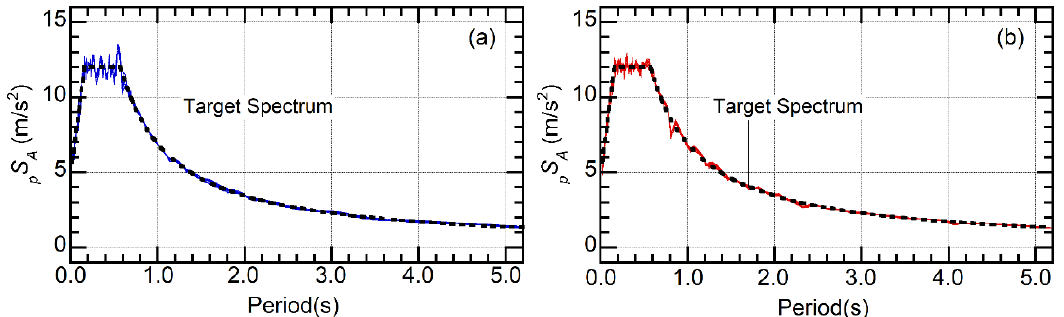
Figure 5. Elastic pseudo acceleration spectrum of the generated artificial ground motions: ( a ) Art-S Series and ( b ) Art-L Series.